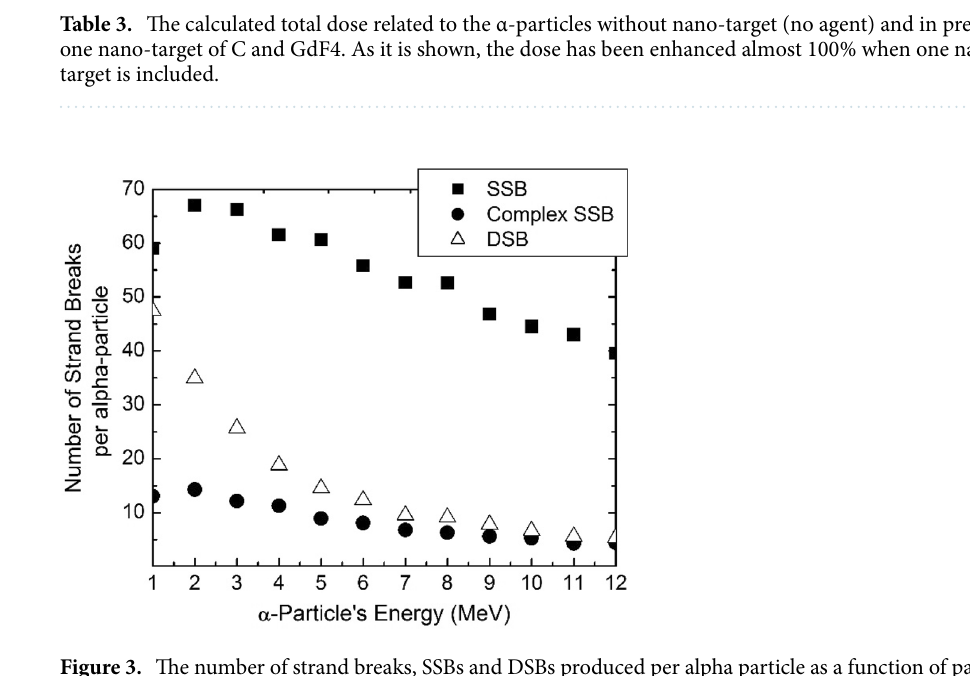
Figure 3. The number of strand breaks, SSBs and DSBs produced per alpha particle as a function of particle’s energy calculated by GEANT4-DNA for the water phantom 0.5 μm side cube. As it is shown, the SSB and DSB curves have maximum values at 2 MeV and 1 MeV, respectively, which correspond to the highest LET values (Table